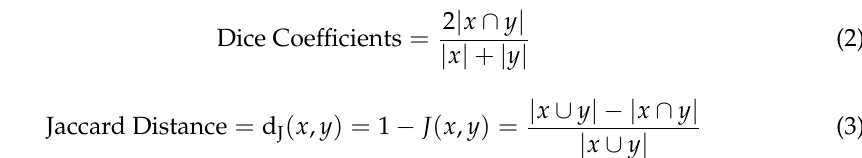
Table 2. In the LIDC-IDRI dataset, the dice coefficients and Jaccard distance obtained by different methods are statistically